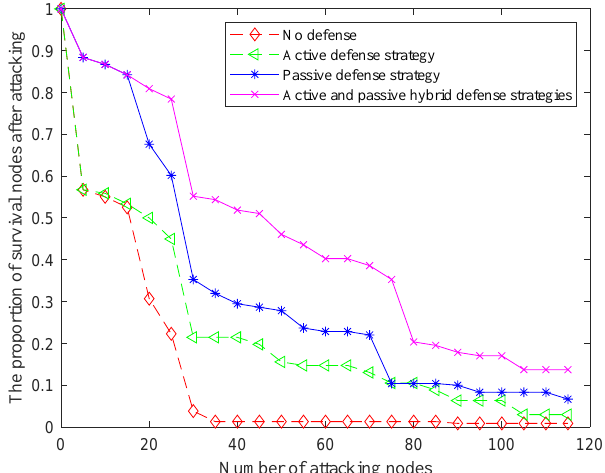
Figure 8. The effect of active and passive defense